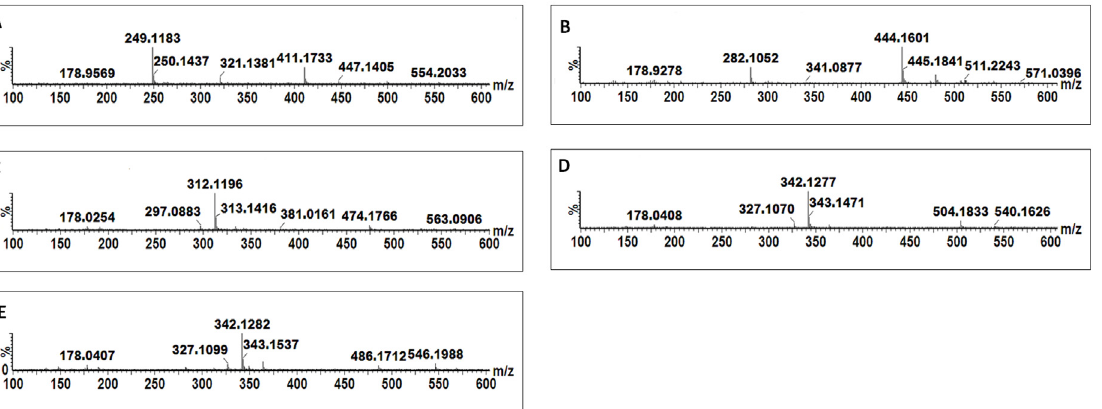
Fig 6. MS spectra showing fragmentation patterns of cinnamic acid derivatives conjugated to nitrogen containing molecules. Caffeoylputrescine glycoside (A) p -coumaroyltyramine glycoside (B), feruloyltyramine glycoside (C) , feruloyl-3-methoxytyramine-4-glycoside (D) and feruloyl- 3-methoxytyramine conjugate (E)